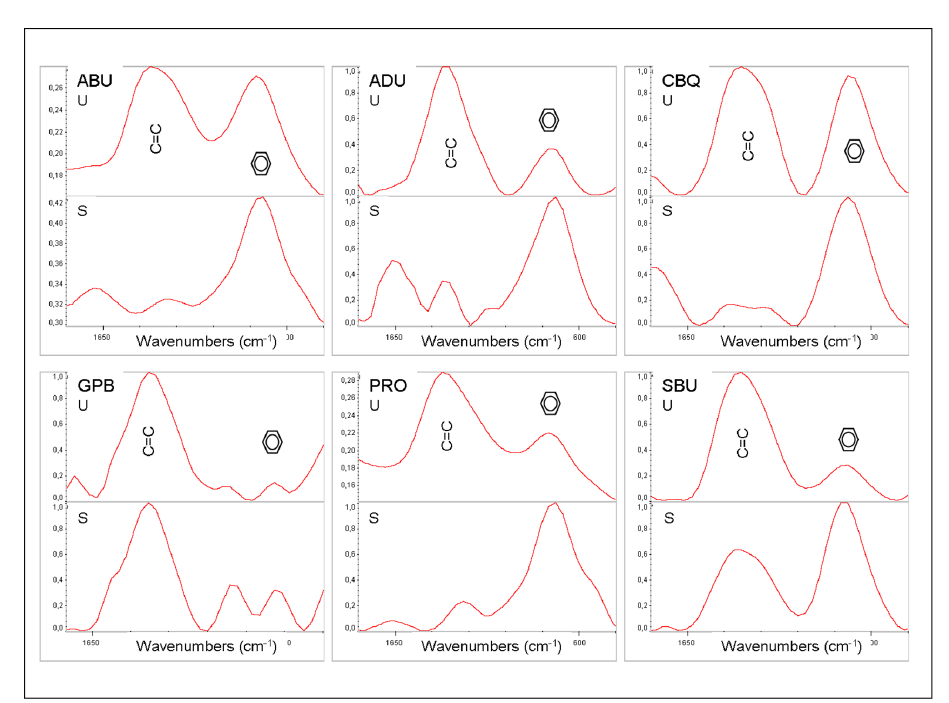
Figure 1. Attenuated total reflectance Fourier transform infrared (ATR-FTIR) spectra of the unset (U) and set (S) films of the universal adhesives used for degree of C=C conversion (DC) measurements, with the C=C and aromatic (hexagon) peak annotations (absorbance scale, 1700–1450 cm − 1 wavenumber range).